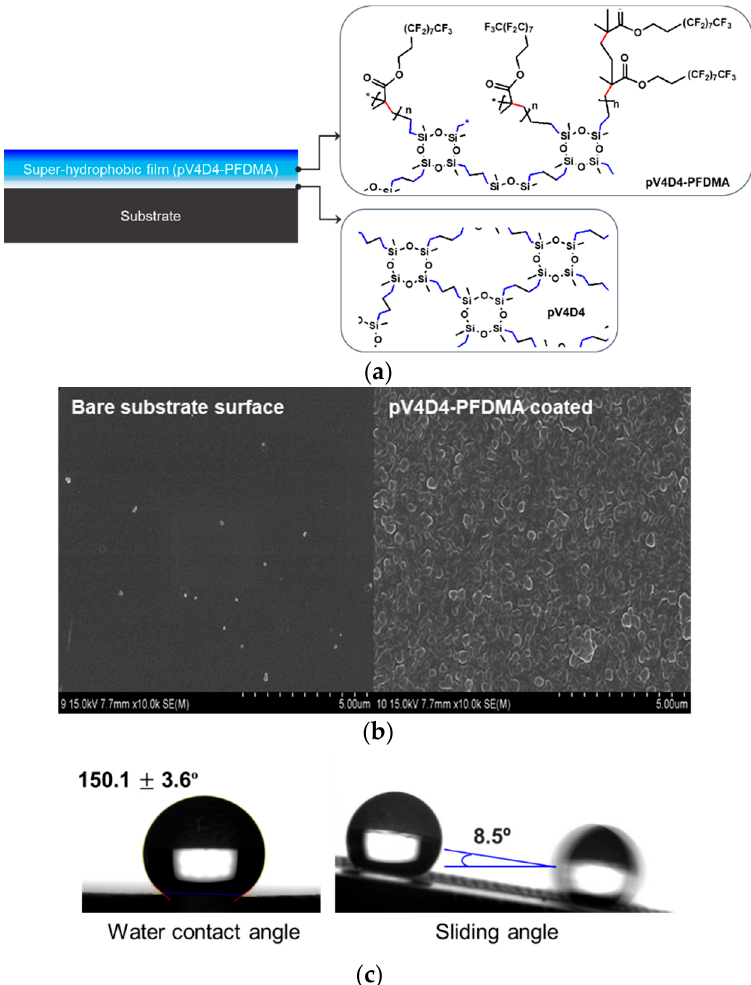
Figure 2. ( a ) A schematic of the fluoropolymer (pV4D4-PFDMA) coating; ( b ) surface morphology using scanning electron microscope (FE-SEM, S-4800, Hitachi, Tokyo, Japan) imaging before and after coating on wafer substrate; ( c ) static and dynamic water contact angles of the pV4D4-PFDMA surface.